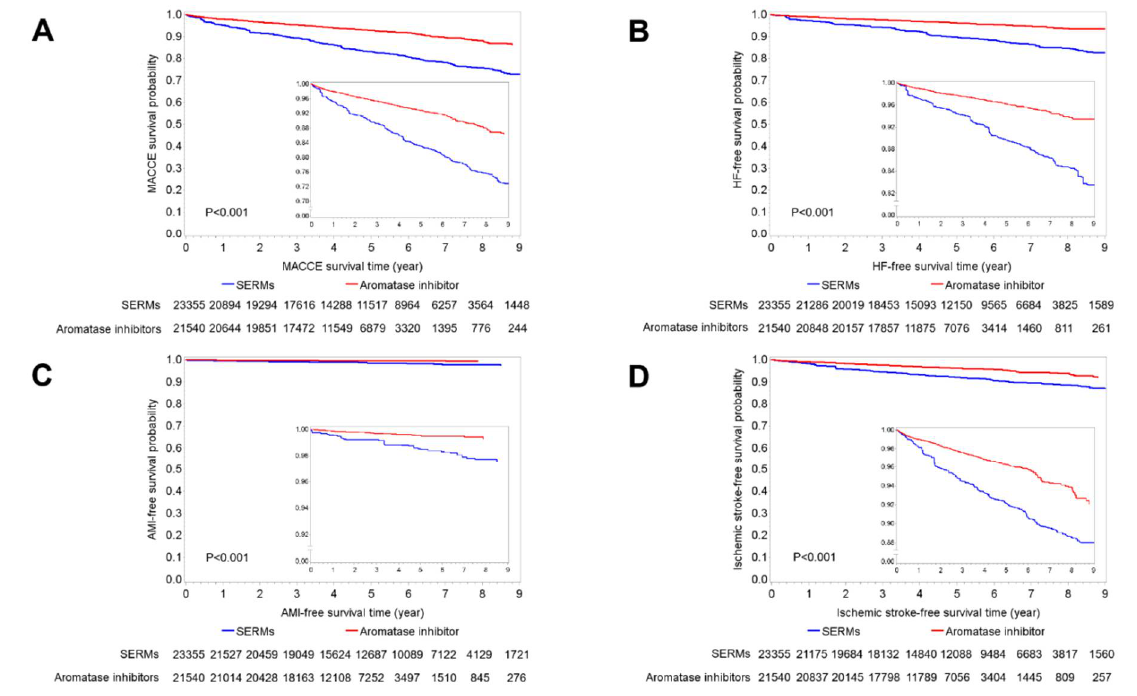
Figure 1. The estimated probabilities of patients being free from ( A ) major adverse cardio-cerebral events (MACCE), ( B ) heart failure (HF) ( C ) acute myocardial infarction (AMI) and ( D ) ischemic stroke among breast cancer patients receiving either selective estrogen receptor modulators (SERMs) or aromatase inhibitors (AIs).